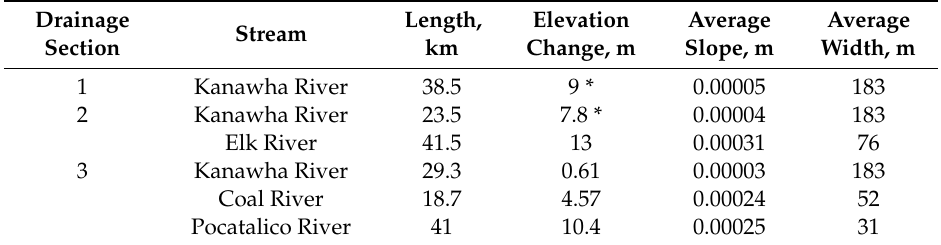
Table 3. Mainstream and tributaries specifications.